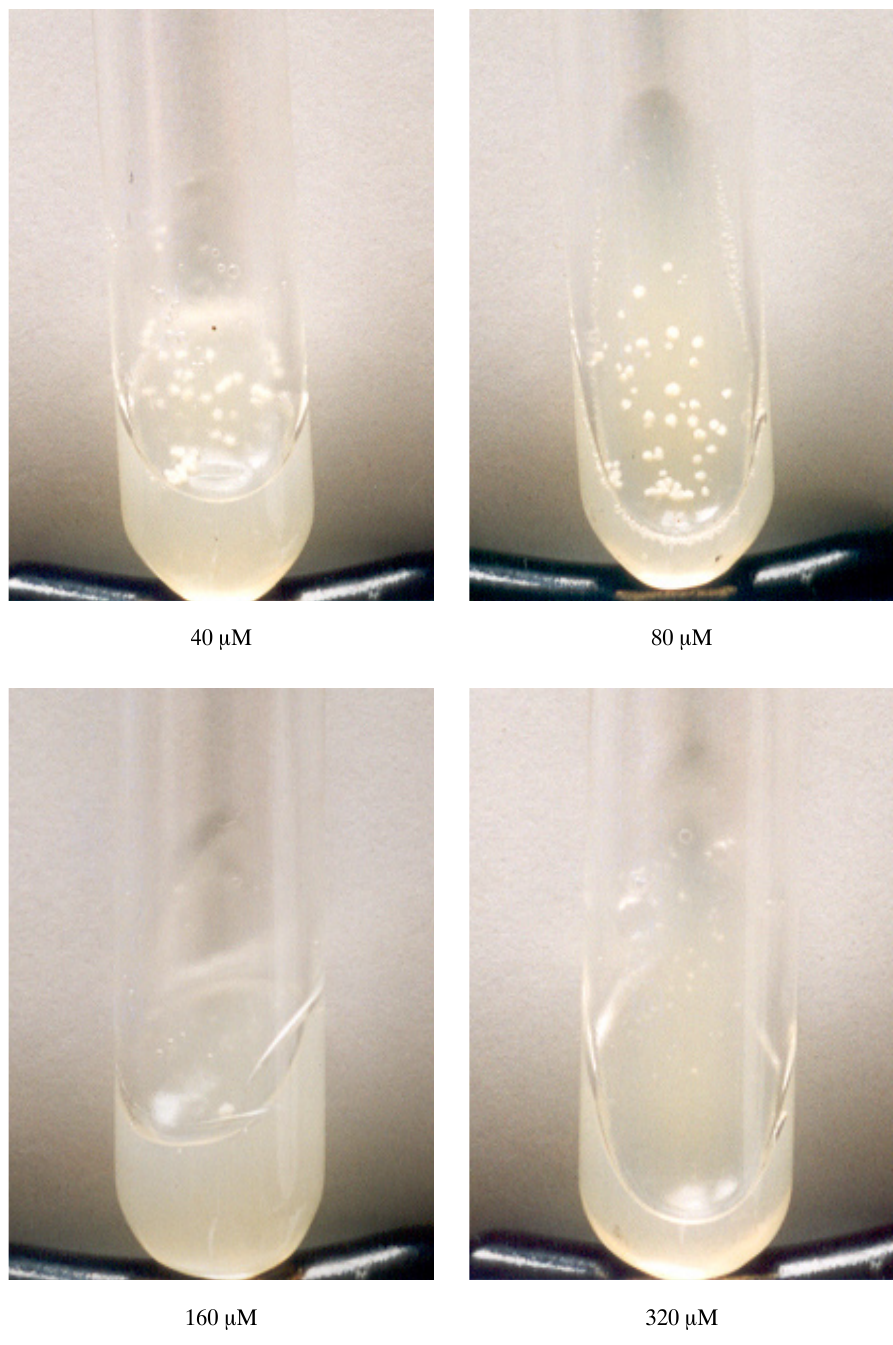
Fig. 5. Growth of Trichosporon cutaneum on the medium YNB at the presence of C14 com-